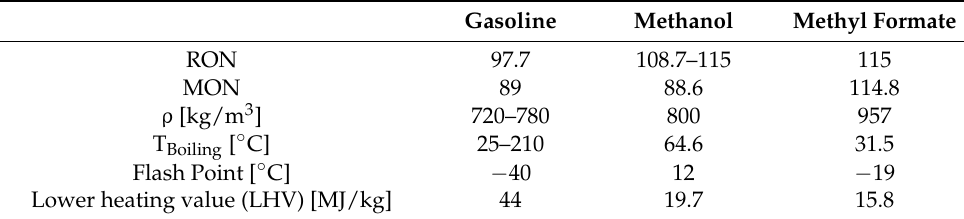
Table 1. Properties of different fuels [7].